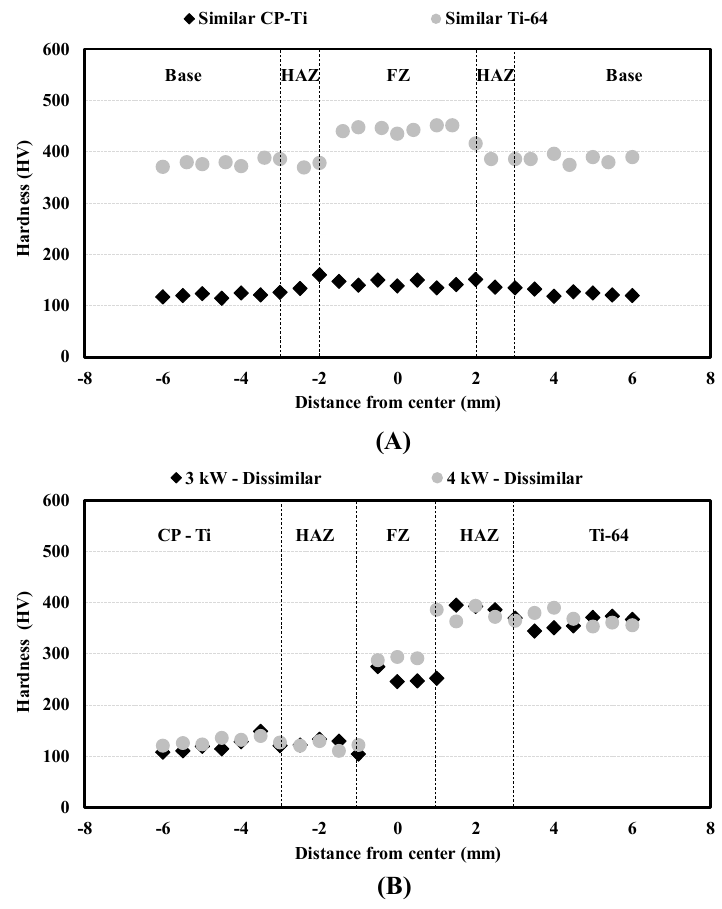
Figure 9. Hardness distribution profile (base to base) for ( A ) similar 3 kW and ( B ) 3 and 4 kW dissimilar joints.